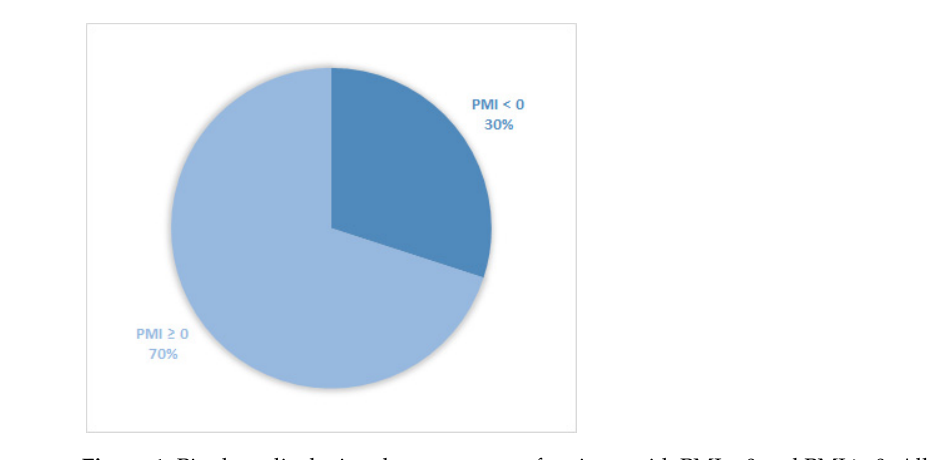
Figure 1. Pie chart displaying the percentage of patients with PMI < 0 and PMI ≥ 0. All patients were included (2104).